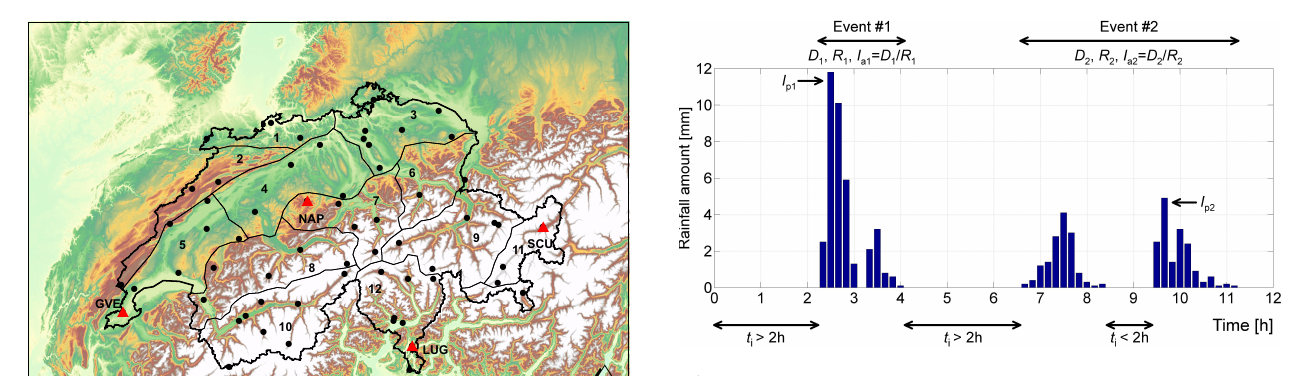
Fig. 2. A schematic to illustrate the identification of independent rainfall events (storms). Symbols: D – event duration, R – total rain- fall depth, I a – average rainfall intensity, I p – peak 10min intensity, t i – inter-arrival